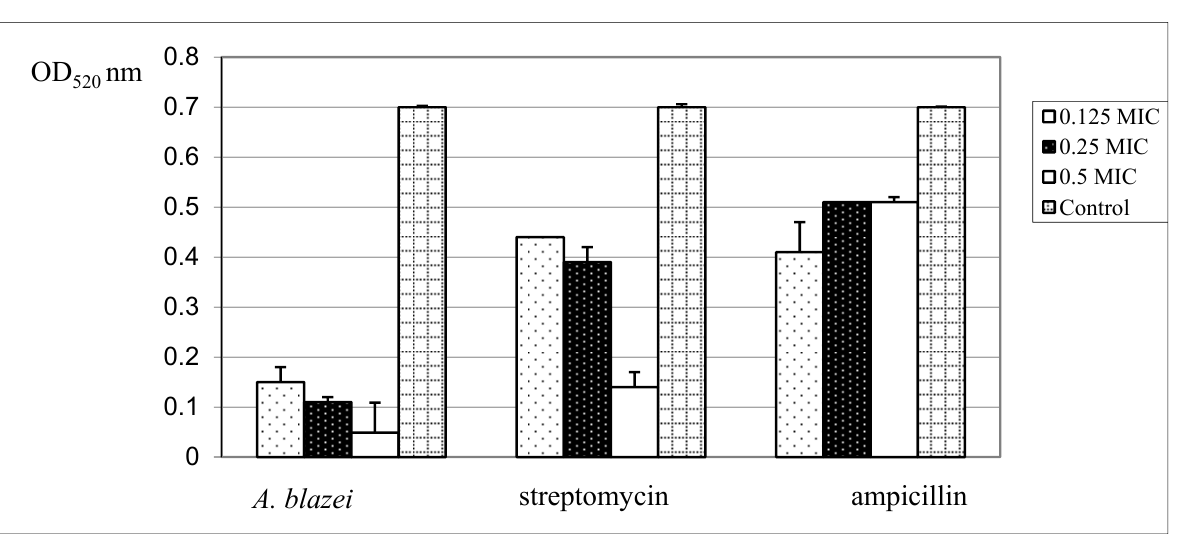
Figure 1. Reduction of pyocyanin pigment production of Pseudomonas aeruginosa by Agaricus blazei extract tested at subMIC, i.e. , 0.5 MIC (0.1 mg/mL), 0.25 MIC (0.05 mg/mL) and 0.125 MIC (0.025